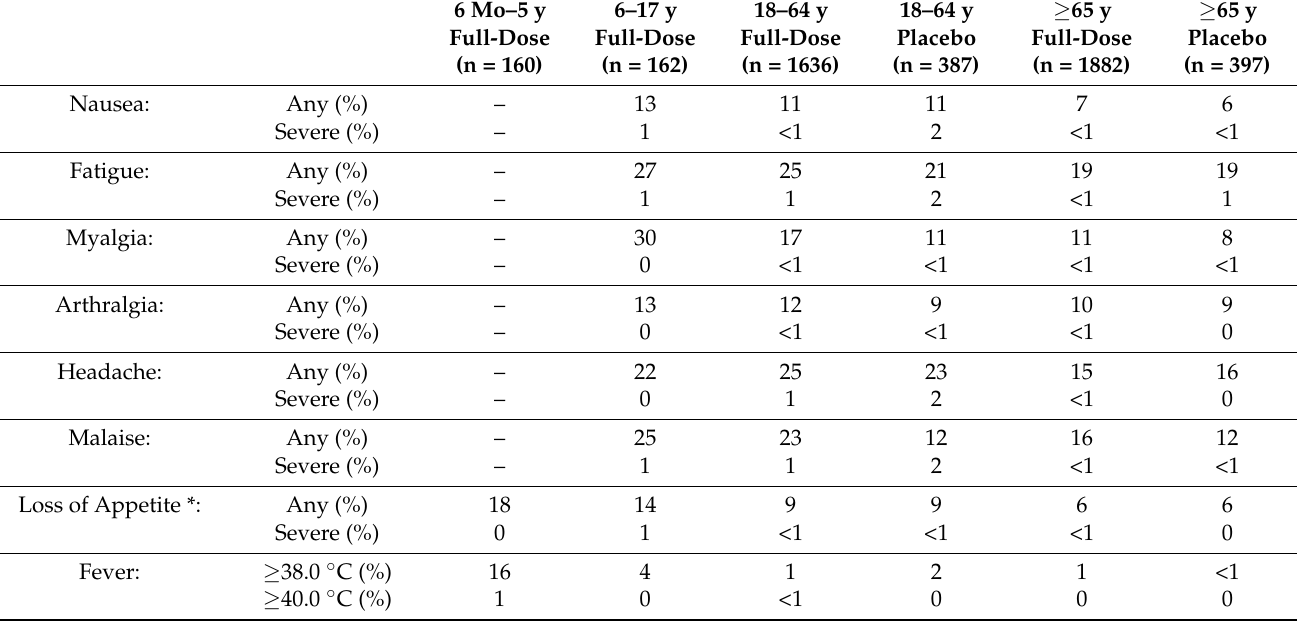
Table 6. Percentages of subjects experiencing solicited systemic adverse events within seven days of any